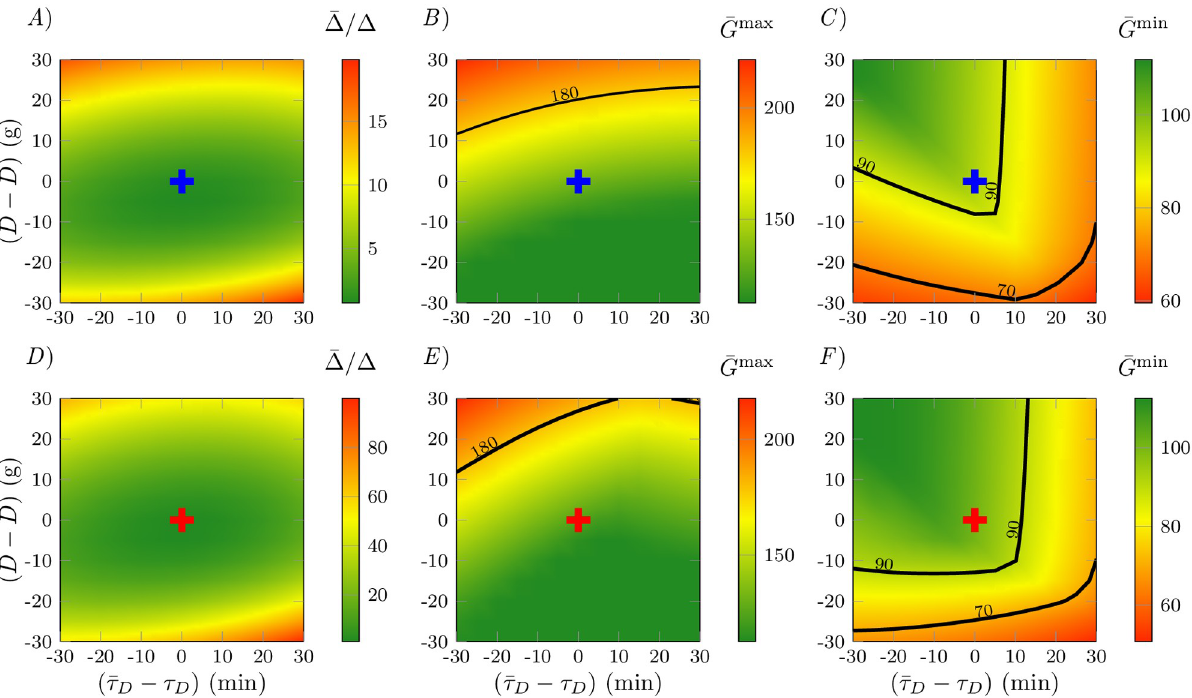
Fig 7. Robustness of the optimal control solution against variations in the meal timing and the amount of glucose in the meal. A )– C ) show the results obtained for the ReNF problem ( p = 1) with only insulin provided, D )- F ) ReMF ( p = 1) problem with both insulin and glucagon provided. Cross symbols indicate the application of the optimal control therapies for � D ¼ D and � t for the ReMF problem with only insulin. The red cross symbols correspond to the optimal therapies for the ReMF problem with both insulin and glucagon. A) and D) are plots of � D = D in the control parameters space ð � t and F) are the plots of � G min in the control parameters space ð � t